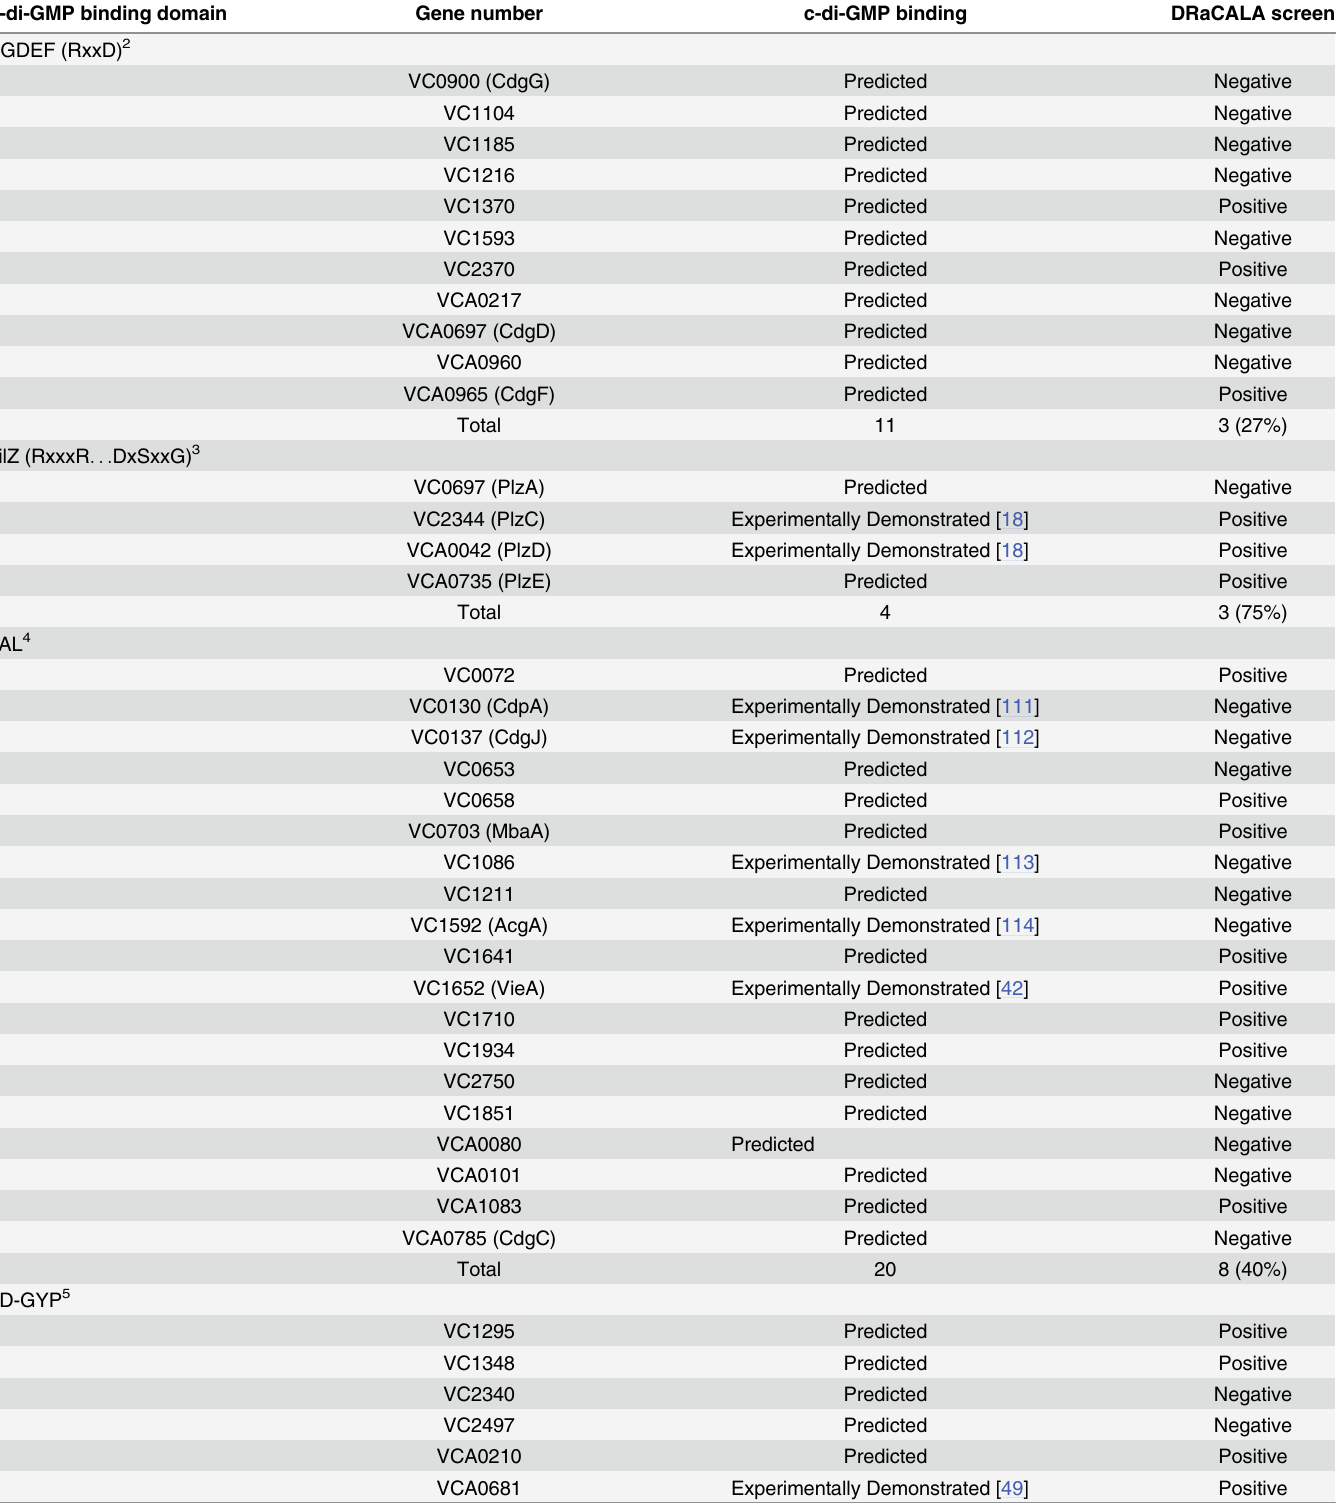
Table 2. Hit rate of V . cholerae ORFs encoding predicted and previously demonstrated cdiGMP-binding proteins.